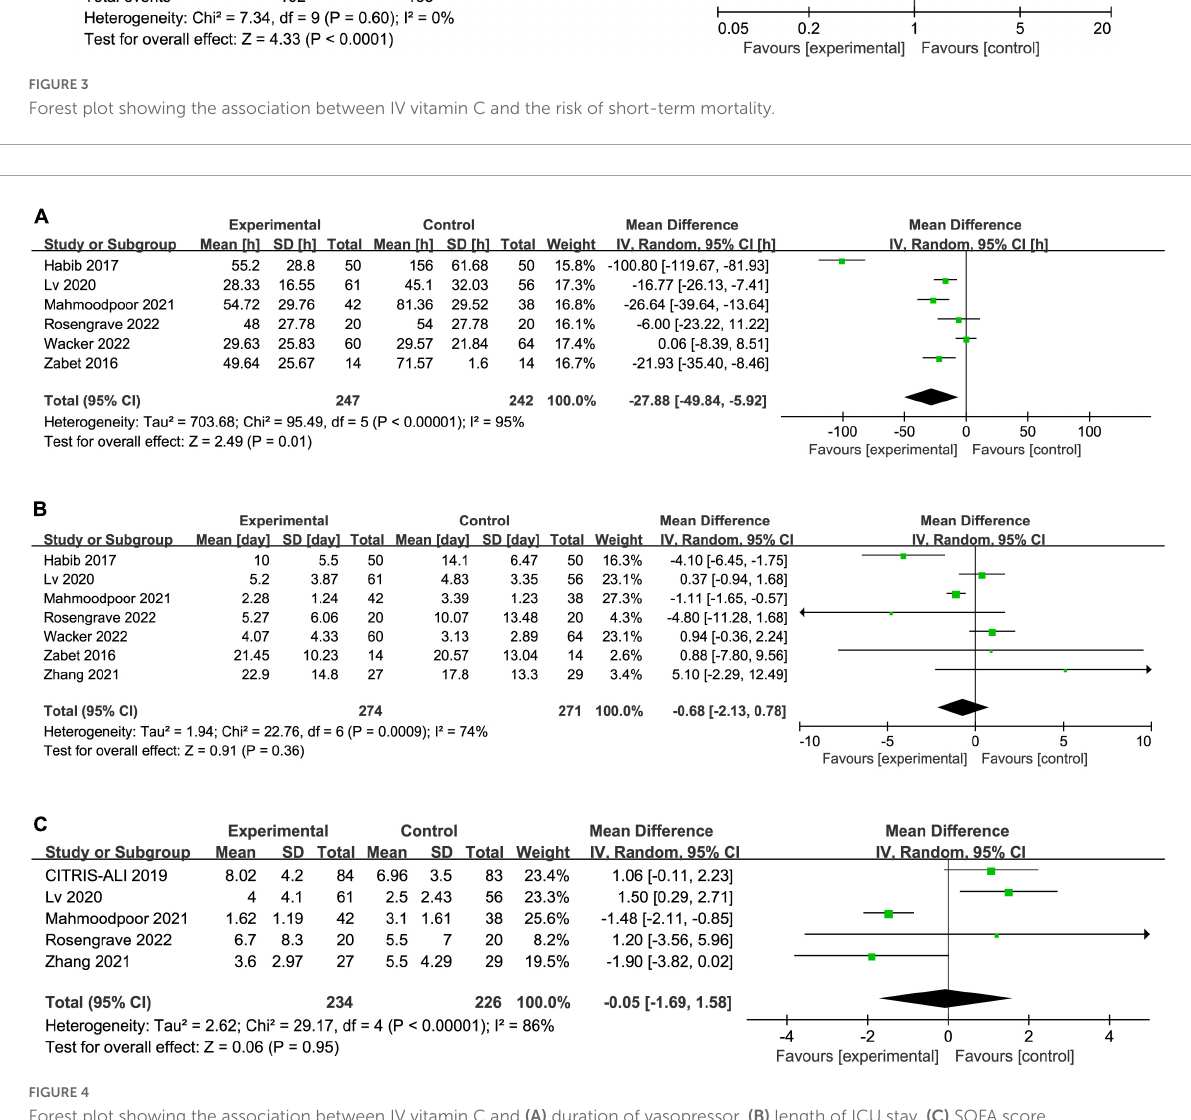
effects of IV vitamin C in patients with sepsis or septic shock. The results of our meta-analysis are approximately consistent with the research by Patel et al. (25) that IV vitamin